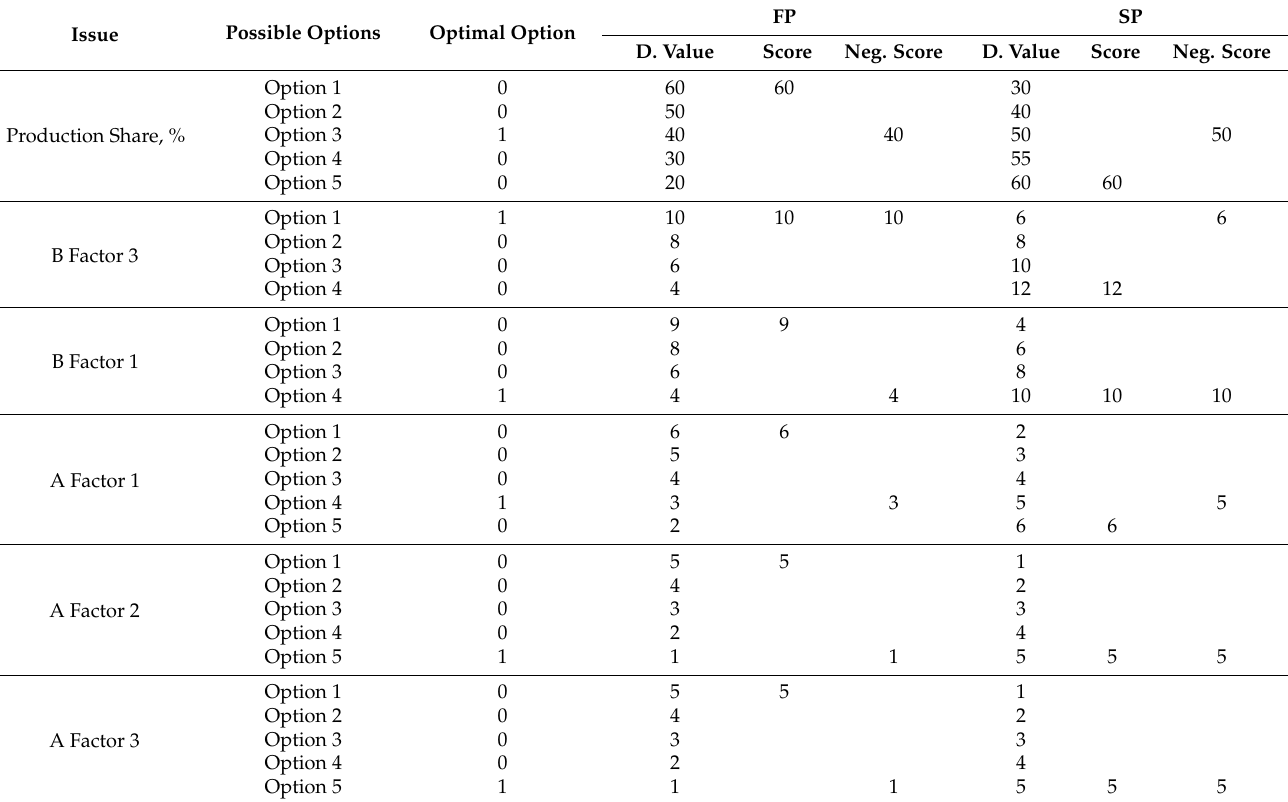
Table 9. Maxi-min solution of the negotiation score of FP and SP using Solver